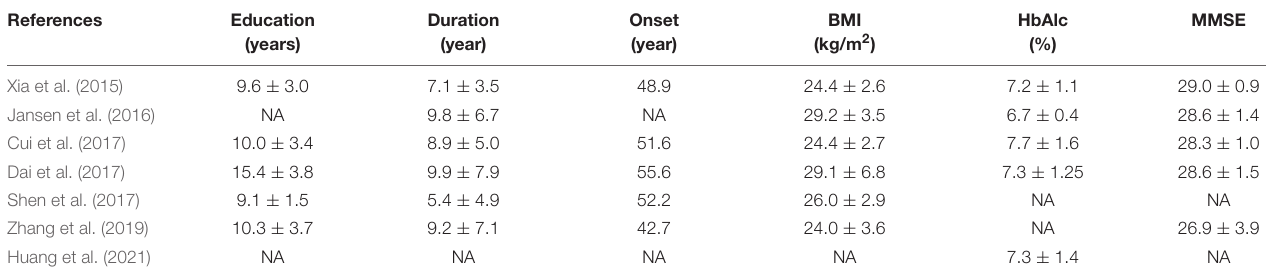
TABLE 2 | Clinical characteristics of the included studies in the meta-analysis.